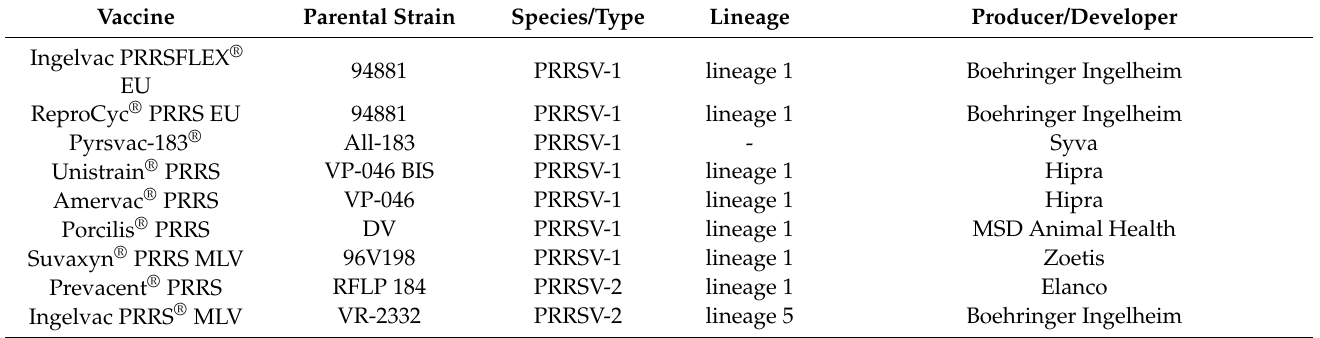
Table 1. Commercially available porcine reproductive and respiratory syndrome (PRRS) modified live virus (MLV) vaccines.